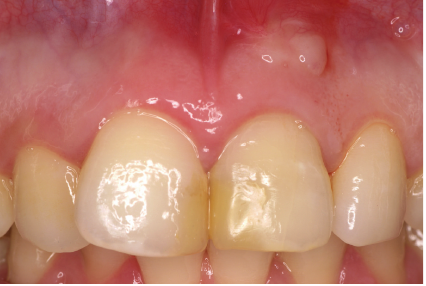
Figure 12: Scar tissue formation at the site of the connective graft.